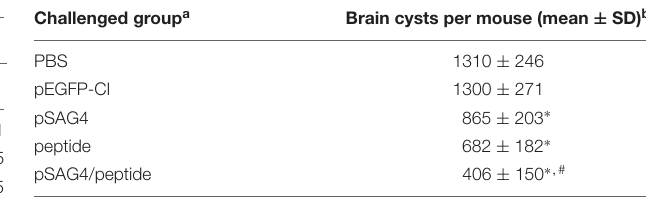
TABLE 4 | The cysts in injected mice after challenge by cysts of PRU